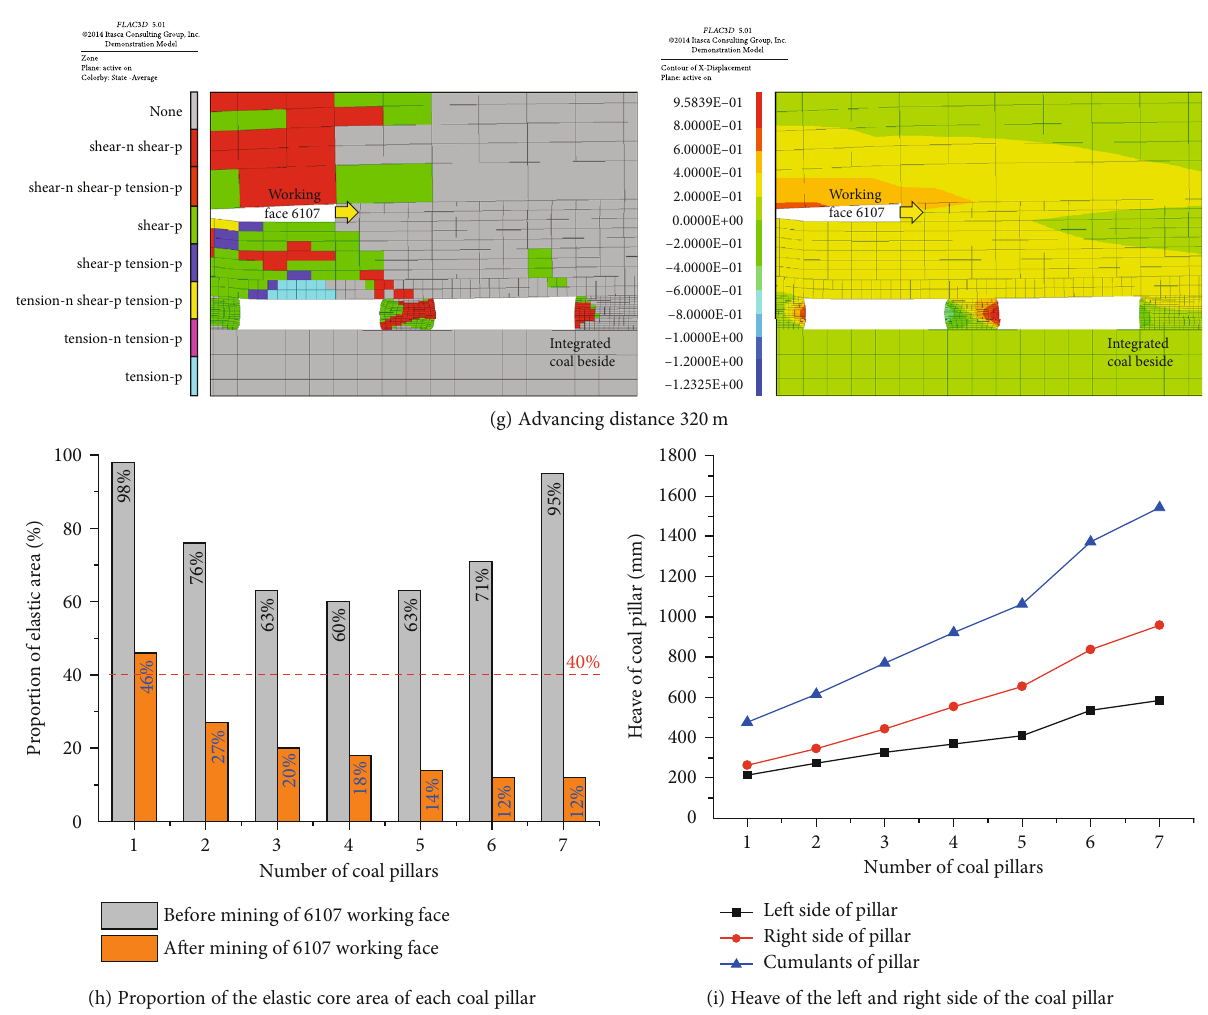
Figure 7: Evolution law of the elastic-plastic property and the amount heave of the left and right side of the coal pillar under di ff erent advancing distances of the no. 6107 working face.